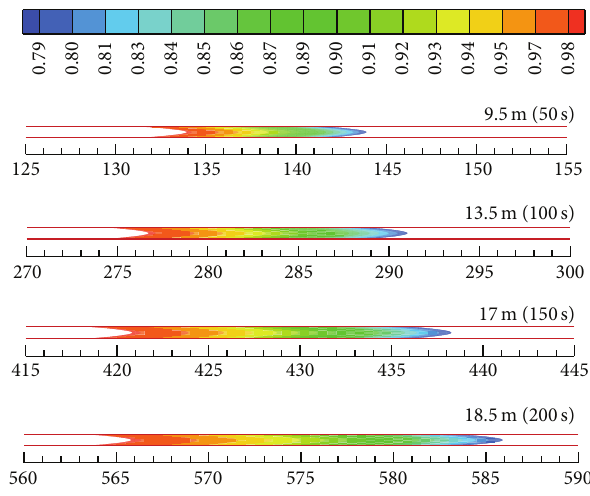
Figure 3: Gas mixture length at different